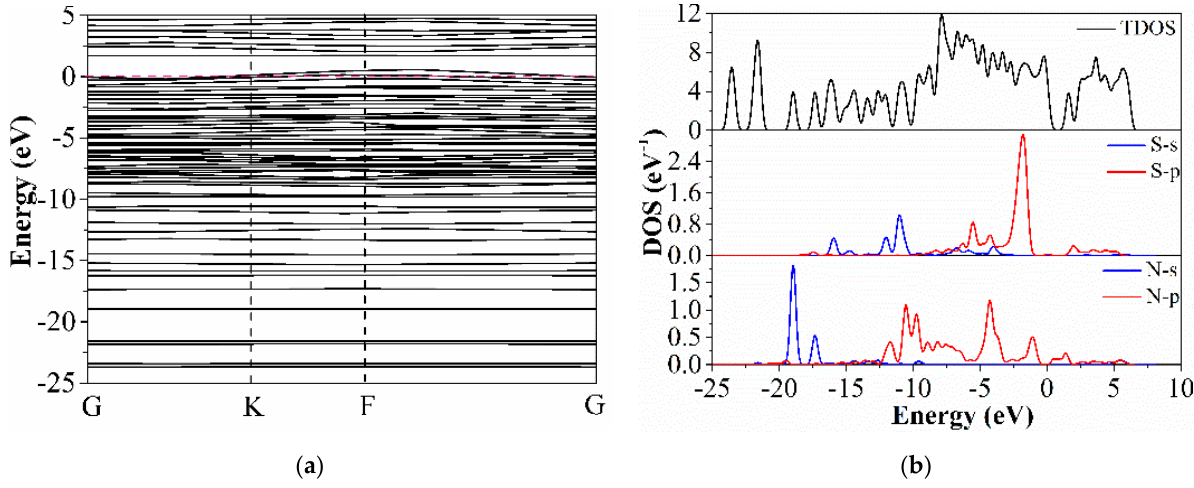
Figure 11. ( a ) Band structure diagram of S-G after ammonia adsorption; ( b ) TDOS diagram of S-G after ammonia adsorption.